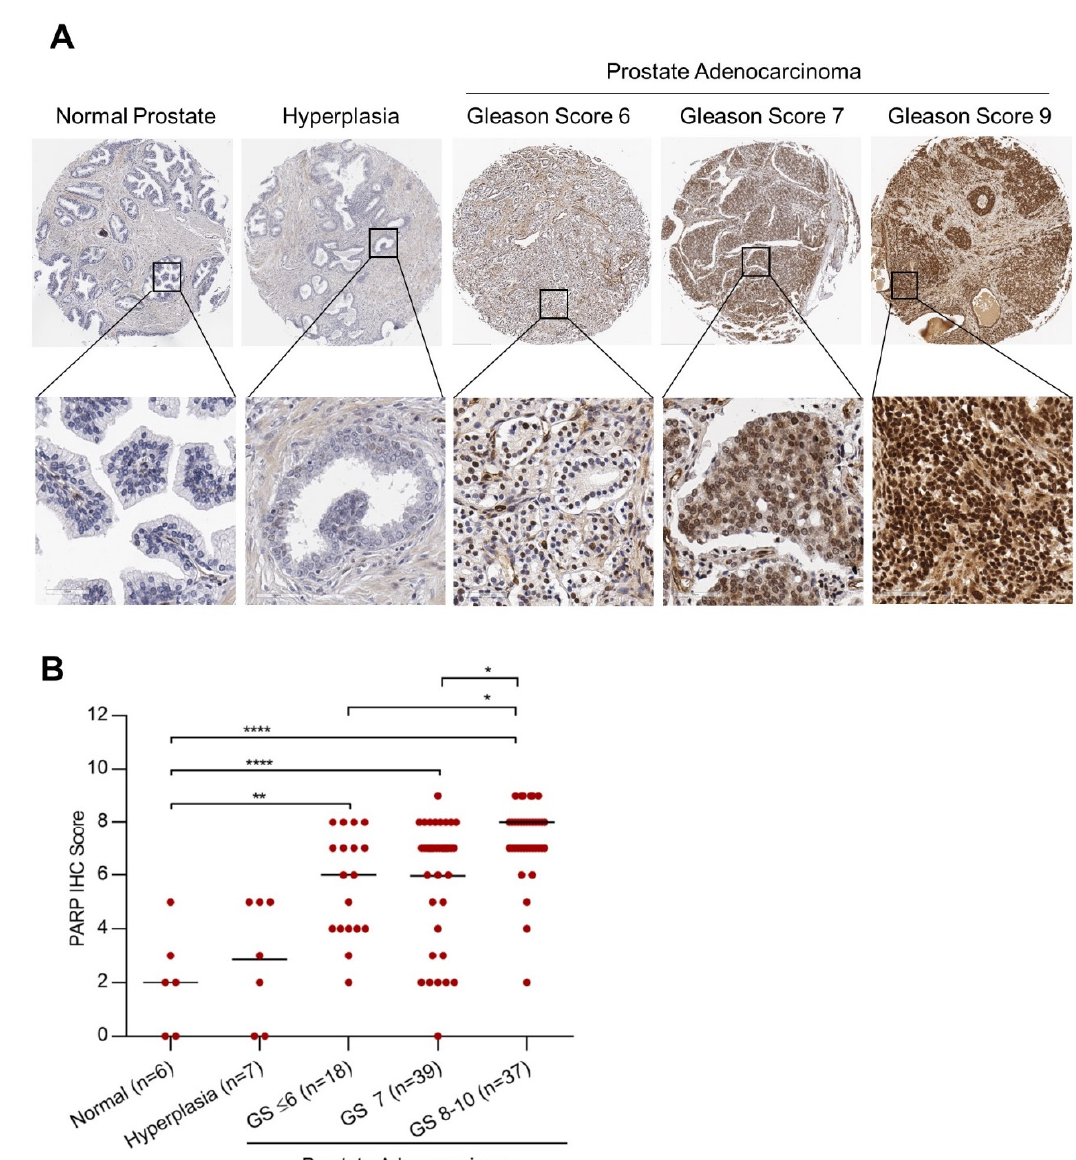
Figure 1. Increase in PARP-1 protein expression with Gleason grade in prostate cancer tissues. ( A ), immunohistochemistry (IHC) staining of PARP-1 in normal human prostate, prostate hyperplasia, and prostate cancer cases graded based on Gleason score in a tissue microarray (TMA). Representative photomicrographs at 4 × (top panel) and 40 × (lower panel) magnification are shown. ( B ), IHC scoring of PARP-1 expression in the TMA cores. Scatter plots showing the distribution of PARP IHC scores. IHC score is calculated as the sum of the PARP-1 positive proportion (0 = no positive tumor cells; 1 = <1%; 2 = 1–10%; 3 =11–33%; 4 = 34–66%; 5 = 67–100%) and the staining intensity (0, no staining; 1, weak; 2, moderate; 3, strong; 4, very strong) for a possible total score of nine. * p < 0.05, ** p < 0.01 and **** p < 0.0001.